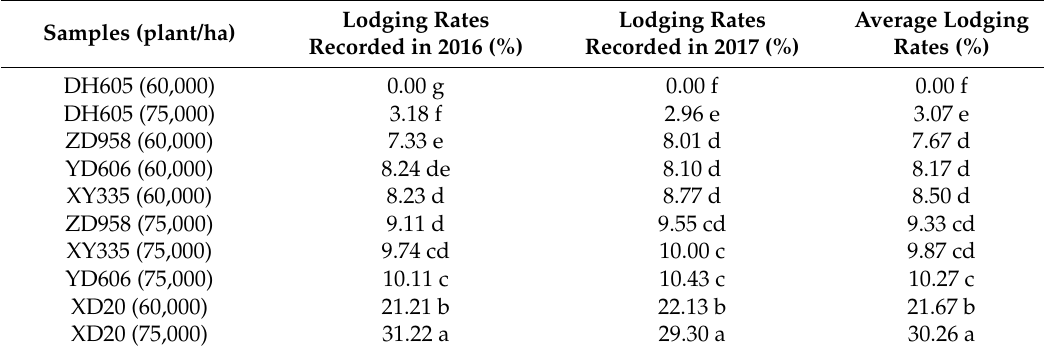
Table 2. The lodging rates recorded from the experimental samples in 2016 and